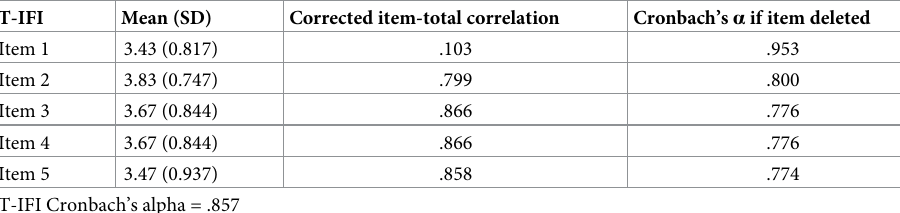
Table 3. Psychometric properties of the Thai Infant Feeding Intentions Scale (n =